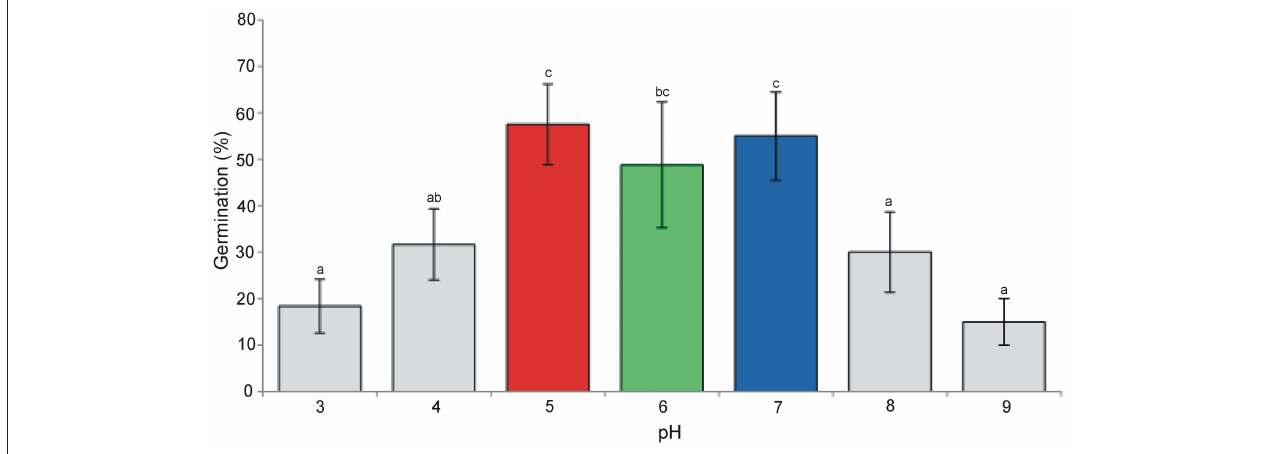
FIGURE 1 | Germination percentage (means + st. dev.) of A. artemisiifolia under different pH values (ANOVA: F = 11.69; df = 6,26; P < 0.001). Different letters indicate significant differences of germination at P < 0.05 level (Tukey multiple comparison test).